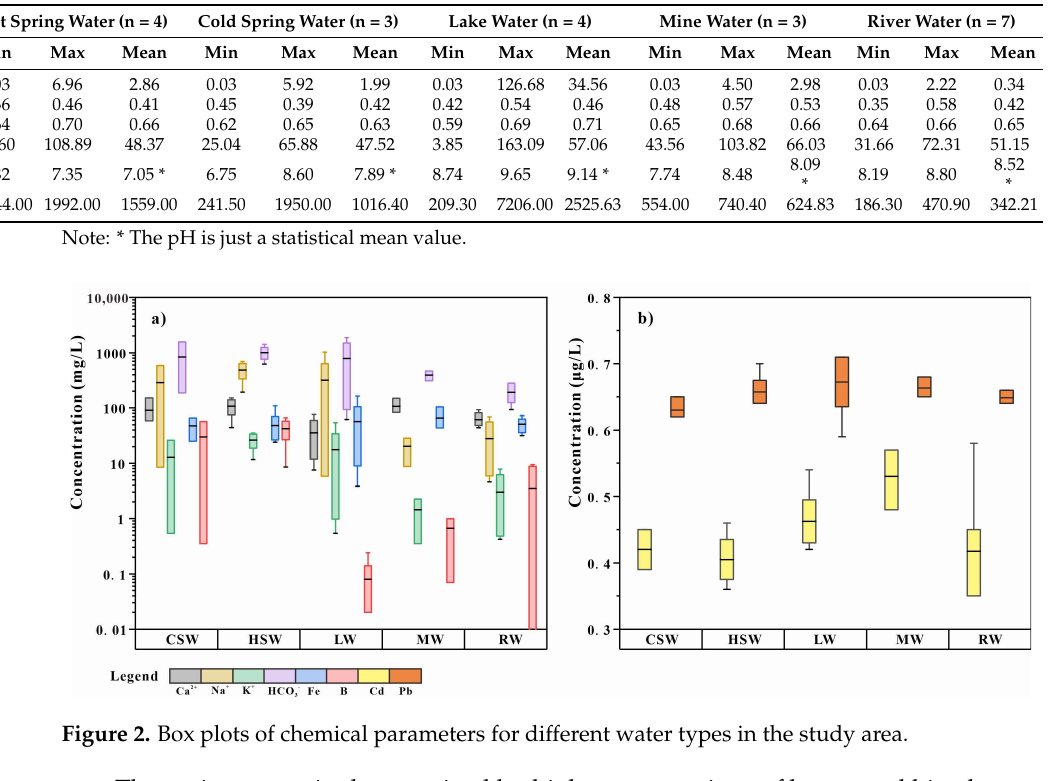
6 of 22 Table 2. Statistical results of chemical parameters for different water types in the study area (unit: mg/L). Parame ‐ ters